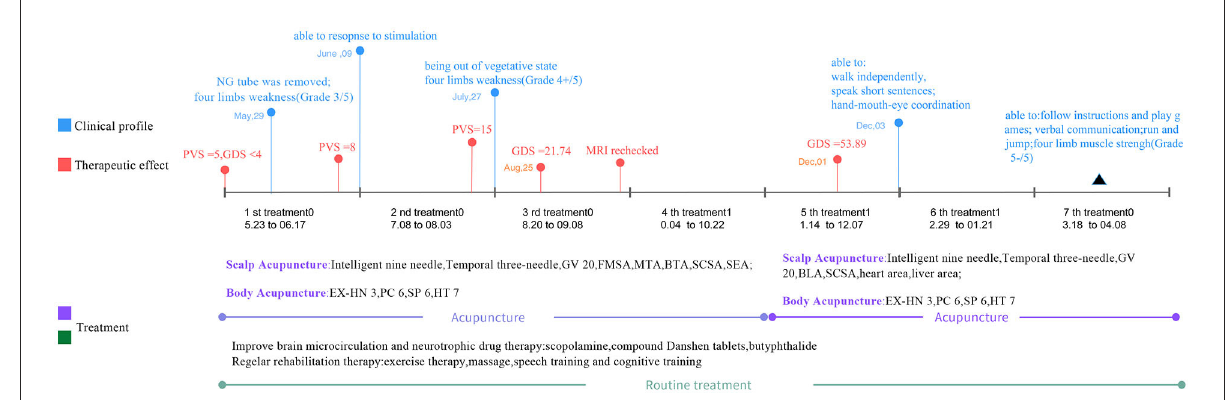
FIGURE2 The timeline of diagnosis and treatment for this patient. NG tube, nasogastric tube; PVS, persistent vegetative state; GDS, Gesell Developmental Schedules; MRI, magnetic resonance imaging; FMSA, Foot motor sensory area; MTA, Motor area; BLA, Balance area; SCSA, Second speech area; SEA, Spirit-emotion area; GV 20, Baihui acupoint; EX-HN 3, Yintang acupoint; PC 6, Neiguan acupoint; HT 7, Shenmen acupoint; SP 6, Sanyinjiao acupoint.